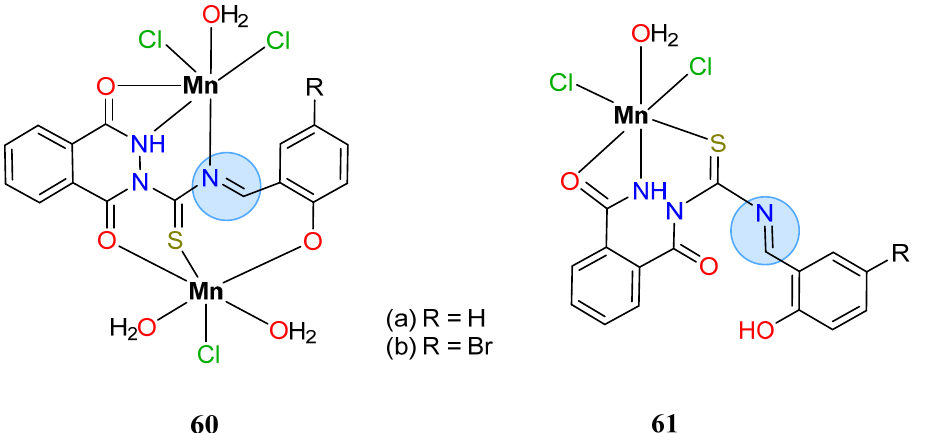
Mn 59 Figure 25. Mn(II) complex from an NNS Schiff base ligand with antimicrobial activity. Refat’s research group reported two SB ligands and their Mn(II) complexes to evalu ‐ ate their biological properties [134]. Through analytical characterization and molecular modelling, Mn(II) complexes were proposed with an octahedral geometry, where manga ‐ nese coordinates with ONN/OSO and ONS atoms to generate dinuclear and mononuclear complexes, respectively (Figure 26). To evaluate the antimicrobial activity, only complex 61 was studied. The agar disc diffusion method was used to test the uncoordinated ligands and their metal complexes at a 100 μ g concentration against the Gram ‐ positive strains B.